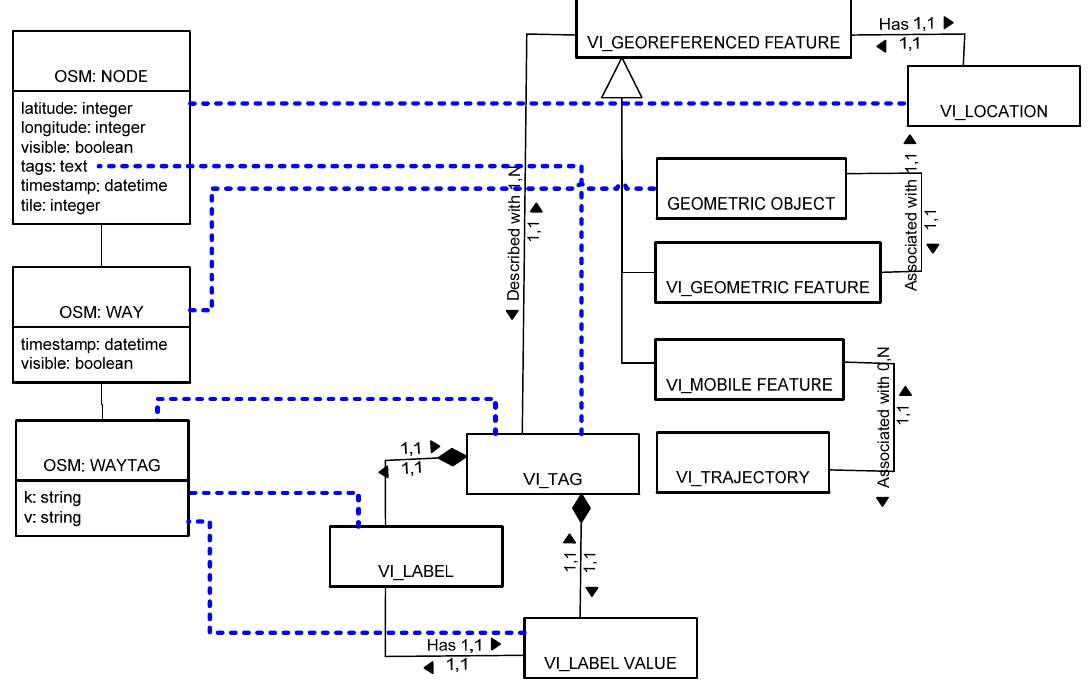
Figure 3. Example of mapping between a VGI application model (OpenStreetMap) and the VGI Semantic